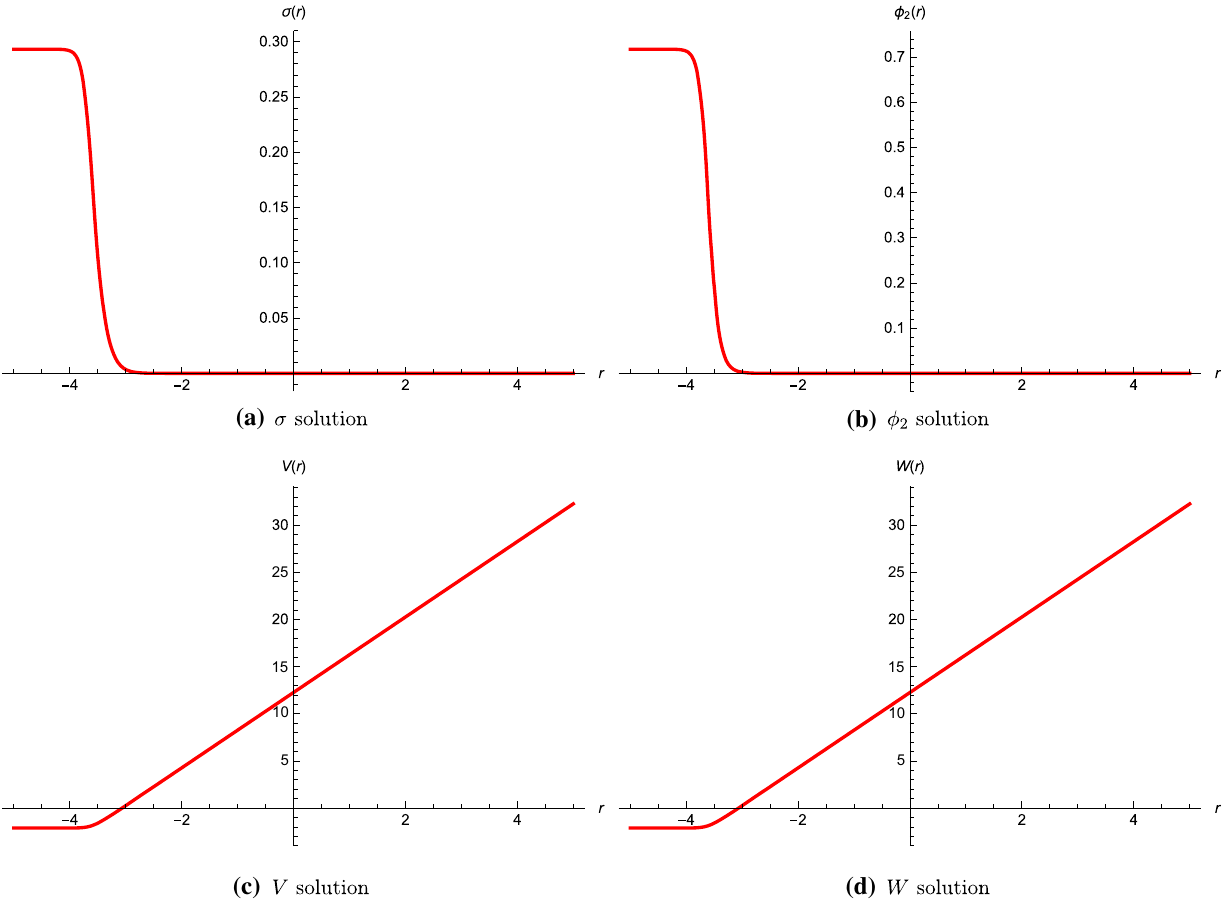
Fig. 5 An RG flow from SO ( 4 ) N = ( 1 , 0 ) SCFT in six dimensions to two-dimensional N = ( 2 , 0 ) SCFT with SO ( 2 ) diag symmetry dual to AdS 3 × H 2 × H 2